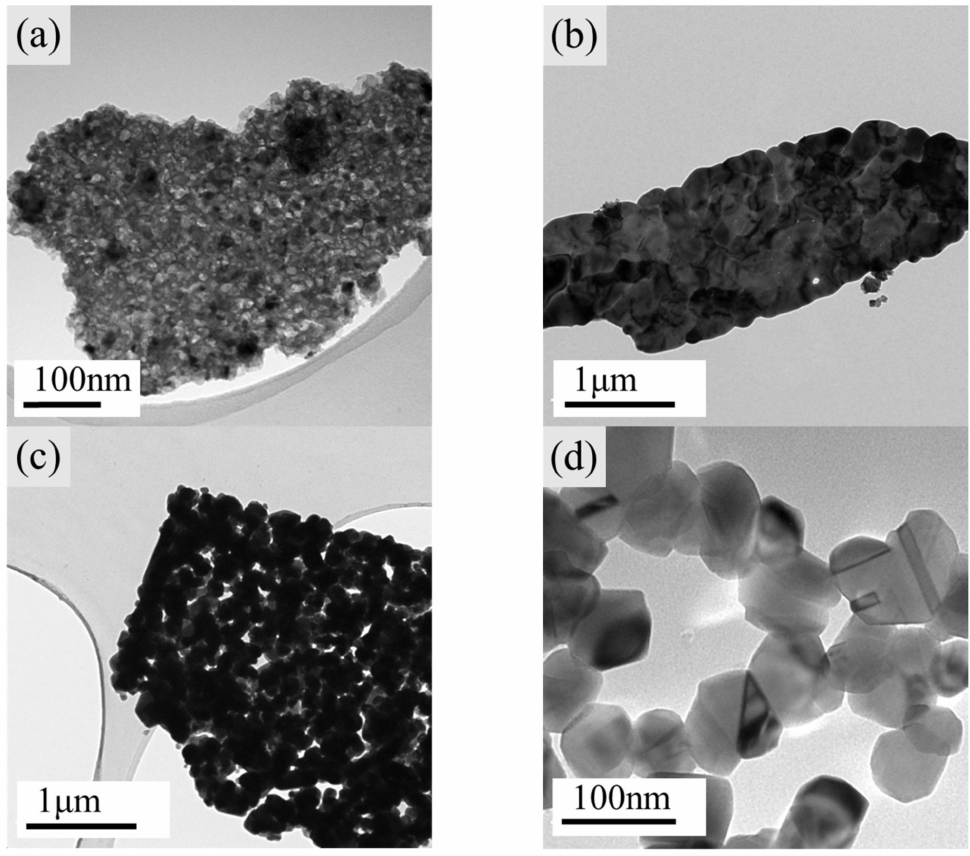
Figure 3. TEM images of ( a ) black powder precursor, ( b ) CCTO-800-3 h-0 t, ( c ) CCTO-800-3 h-3 t, and ( d ) CCTO-3 h-10